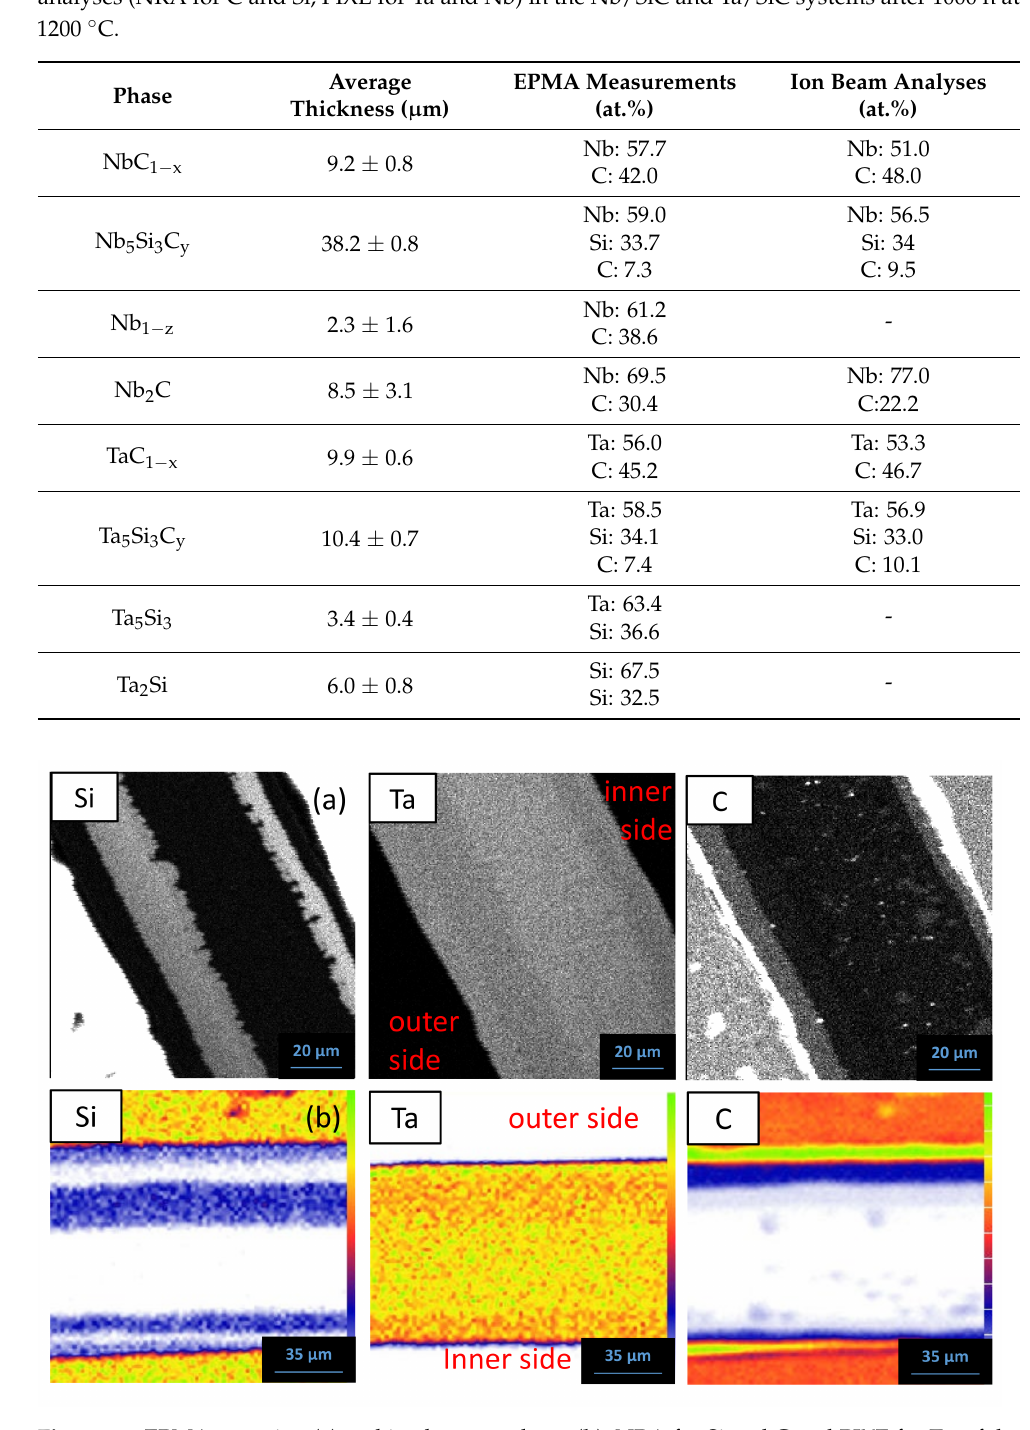
Figure 10. EPMA mapping ( a ) and ion beam analyses ( b ), NRA for Si and C and PIXE for Ta, of the reaction zone of a Ta sandwich cladding after 1000 h at 1200 ◦